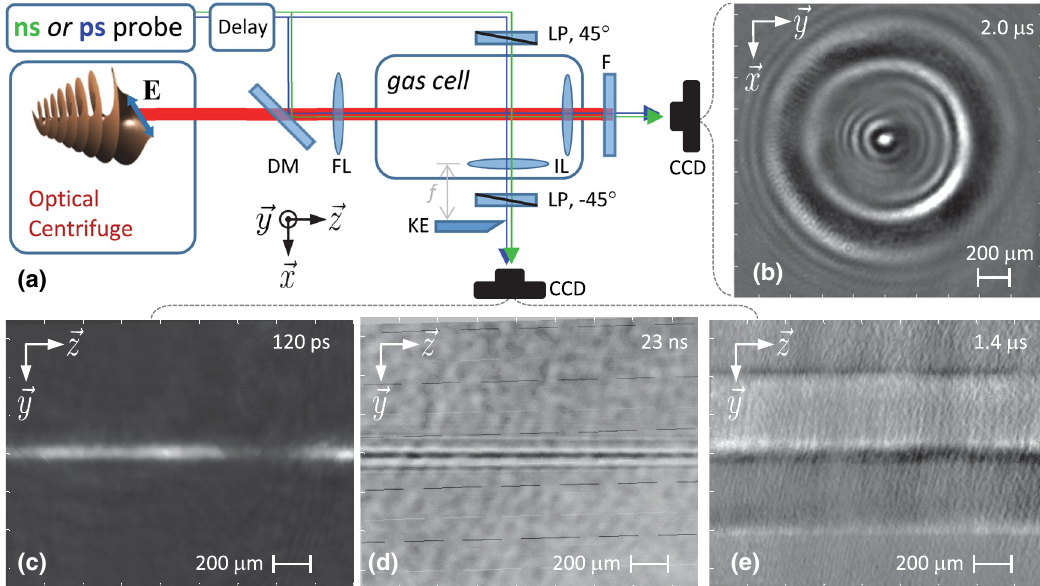
FIG. 1. Schematic diagram of the experimental setup. An ensemble of molecular superrotors is created in a gas cell with an optical centrifuge (red beam). Nanosecond or picosecond probe pulses (green and blue beams, respectively) are delayed with respect to the centrifuge pulses and propagate either collinear with or perpendicular to the centrifuge, creating an image of the rotationally excited volume of gas on a CCD camera either in the longitudinal or transverse direction, respectively. DM: dichroic mirror; FL: focusing lens; IL: imaging lens; KE: knife edge (shown along the y instead of the z axis for clarity); LP: linear polarizers at (cid:1) 45 ° to the y axis; F: frequency filter. An example of the longitudinal image with a circularly expanding sound wave is shown in the upper right corner, panel (b). Images in the lower row were taken in the transverse geometry at early (c), intermediate (d), and late (e) time moments. The leftmost image (c) was recorded with the two linear crossed polarizers in place. The rightmost schlieren image (e) was recorded with the knife edge in